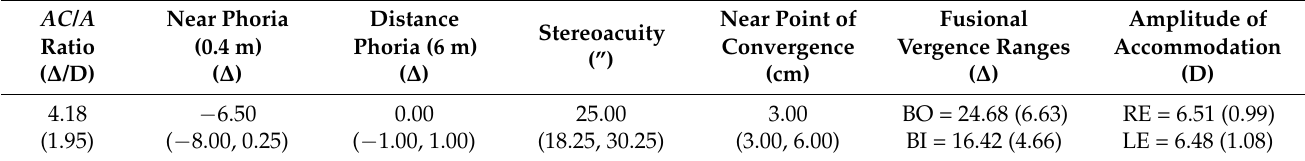
Table 1. Baseline optometric parameters. Results are shown as either mean (standard deviation) or median (interquartile range). Esophoria is expressed as positive values and exophoria as negative